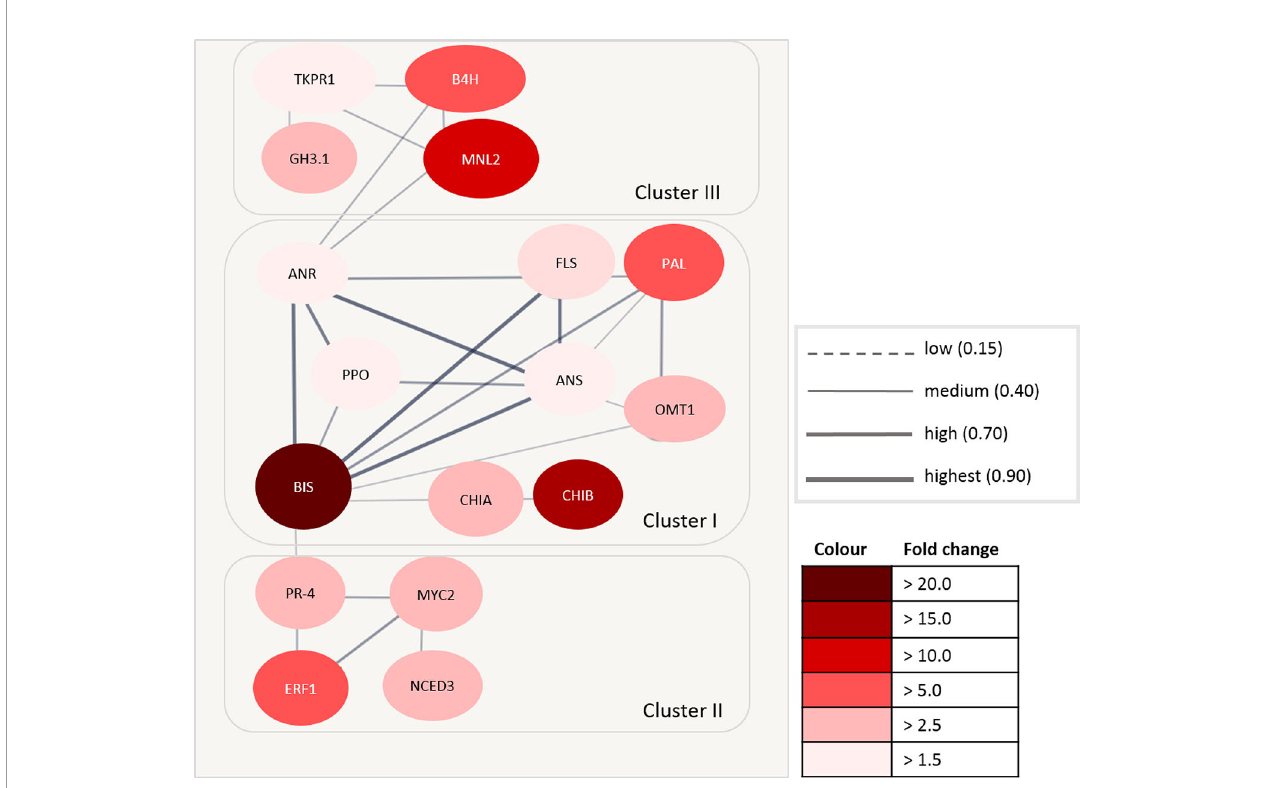
FIGURE 7 | Protein – protein interaction matrix using The Arabidopsis Information Resource (TAIR) accession number of differentially expressed genes (DEGs) in Malus . The circles represent the proteins, and the lines between circles represent the interaction between individual proteins. The thickness of the lines de fi nes the con fi dence of the interaction. The intensity of the red color indicates the fold change expression value (ARD soil/ g ARD soil). ANR , anthocyanidin reductase; ANS , anthocyanidin synthase; B4H , biphenyl 4-hydroxylase; BIS , biphenyl synthase; CHIA , acidic endochitinase-like; CHIB , endochitinase EP3-like; ERF1 , ethylene- responsive transcription factor 1; FLS , fl avanone 3-hydroxylase; GH3.1 , indole-3-acetic acid-amido synthetase; MNL2 , putative mannosidase; NCED3 , nine-cis- epoxycarotenoid dioxygenase 3; TKPR1 , tetraketide alpha-pyrone reductase 1; MYC2 , transcription factor MYC2; OMT1 , O-methyltransferase 1; PAL , phenylalanine ammonia-lyase; PPO , polyphenol oxidase; PR-4 , pathogenesis-related protein